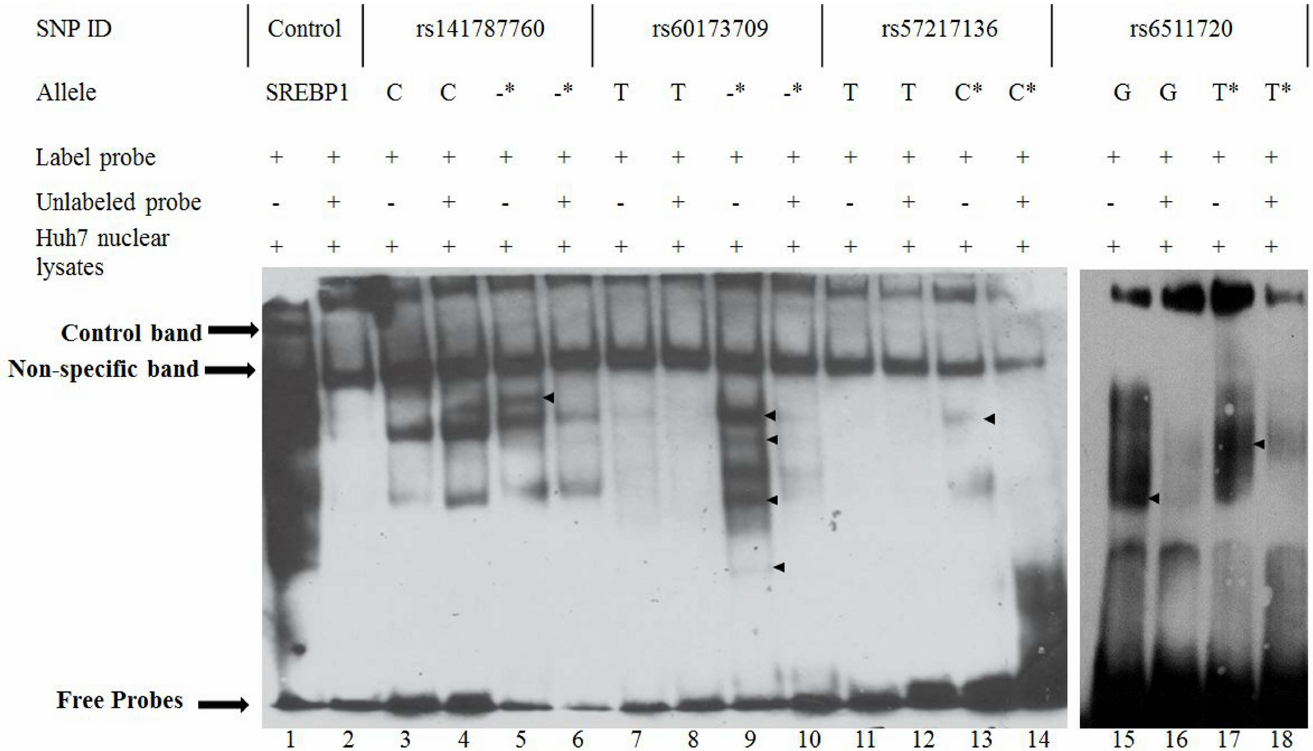
Fig 2. DNA binding properties of LDLR intron-1 SNPs. Conventional EMSA analysisof the LDLR intron-1 SNPs (rs6511720, rs141687760, rs60173709, and rs57217136). Binding of SREBP1 was used as the control (lane 1 and 2). The lanes with a labeledprobe showeda specific band indicatedby arrows, whilewhen the unlabeled probe was added the band disappeared. These four SNPs have allele-specificbinding,indicatedby arrows. (-) = deletion and ( * ) = minor